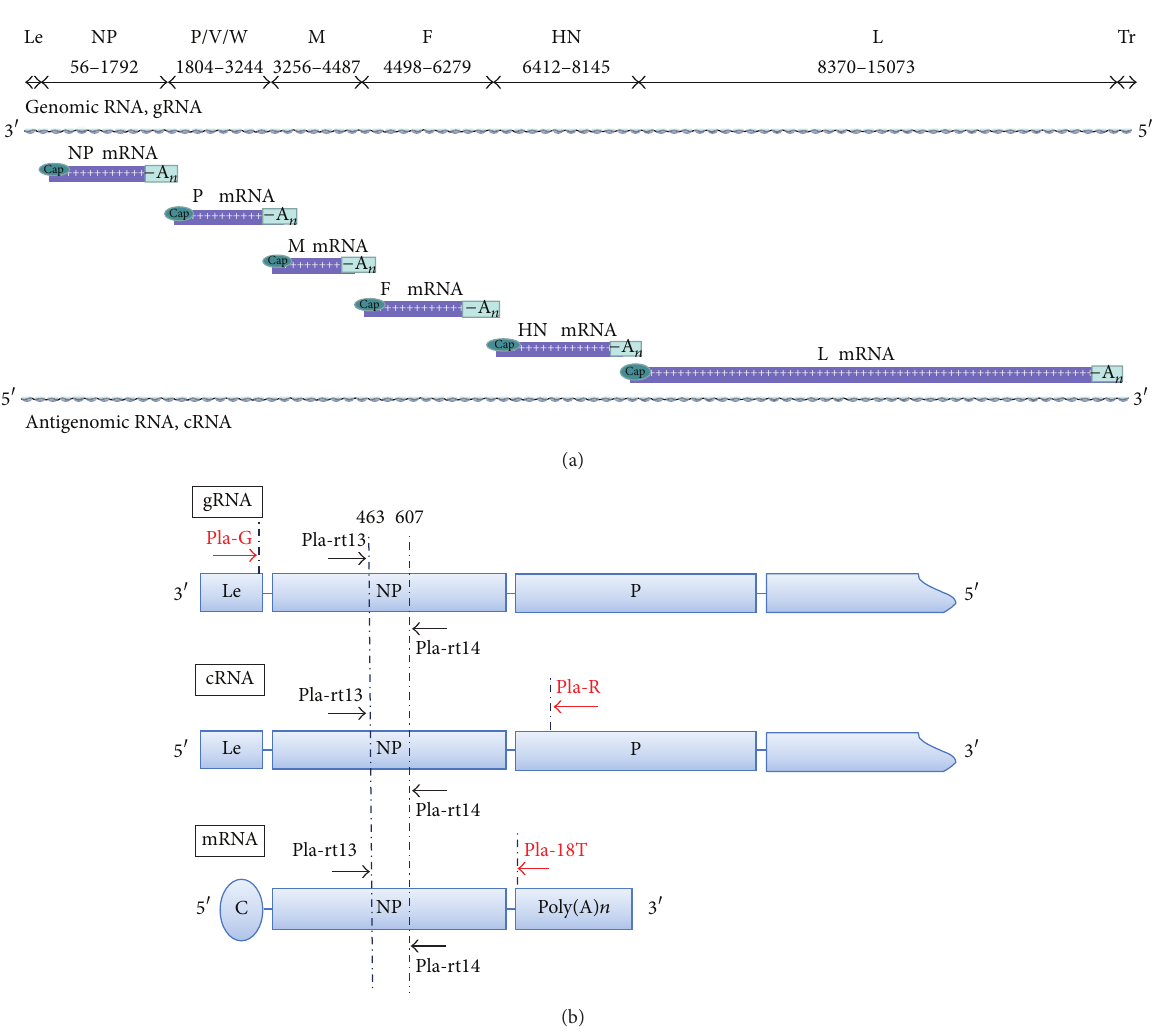
Figure 1: Schematic chart of primer design. (a) Schematic view of NDV genomic organization, main RNA species, and nucleotide positions. (b) Binding position of RT-qPCR primers. Red arrows represent the locations of primers for reverse transcription. Black arrows represent the locations of primers for real-time RT-PCR